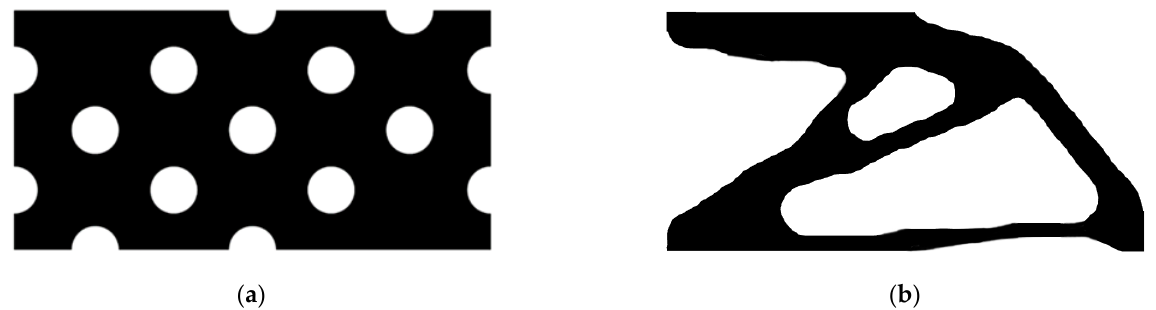
Figure 23. Optimal design problem of cantilever beam by classical level set topology optimization, ( a ) initial shape; ( b ) optimized shape.